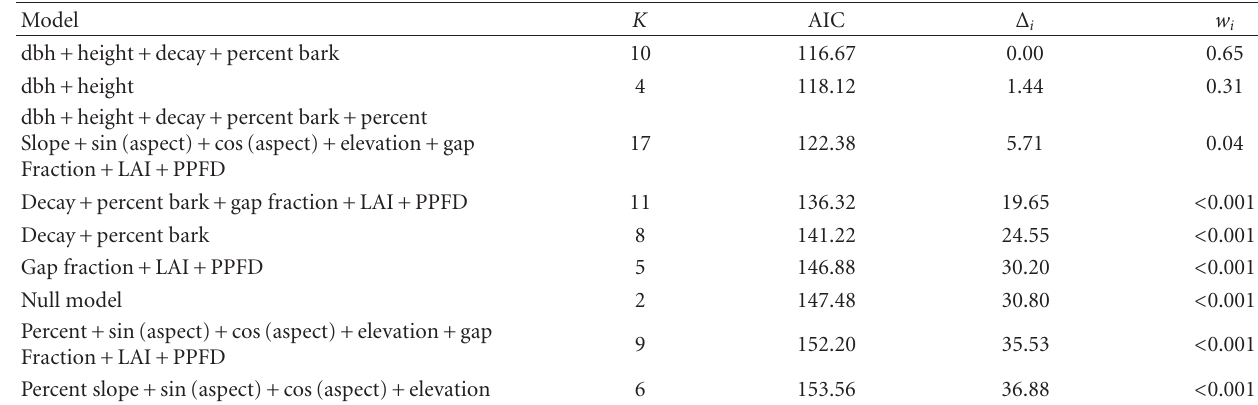
Table 6: Rankings of models used to compare Myotis septentrionalis sassafras day roosts to day roosts of other species on the Fort Knox mili- tary reservation in Hardin, Bullitt, and Meade counties, Kentucky, USA, 2011. Model parameters are given as well as number of parameters ( K ), Akaike’s information criteria (AIC) value, di ff erence in AIC value between top model and i th model ( Δ i ), and model support ( w i ).